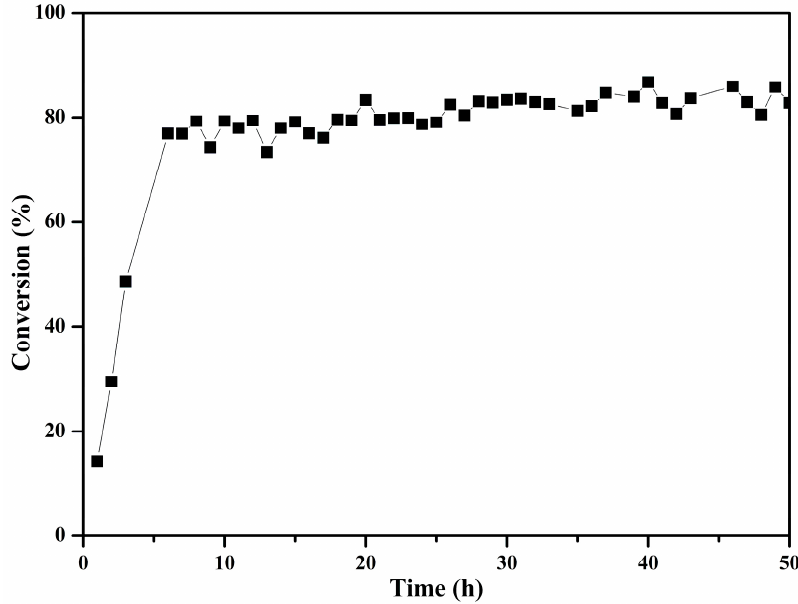
Figure 4. Methane conversion of the aging test for the PdAg/Z-500 catalyst at 350 °C for 50 h. The feed gas consisting of CH 4 :O 2 = 1:2, GHSV = 72000 h − 1.